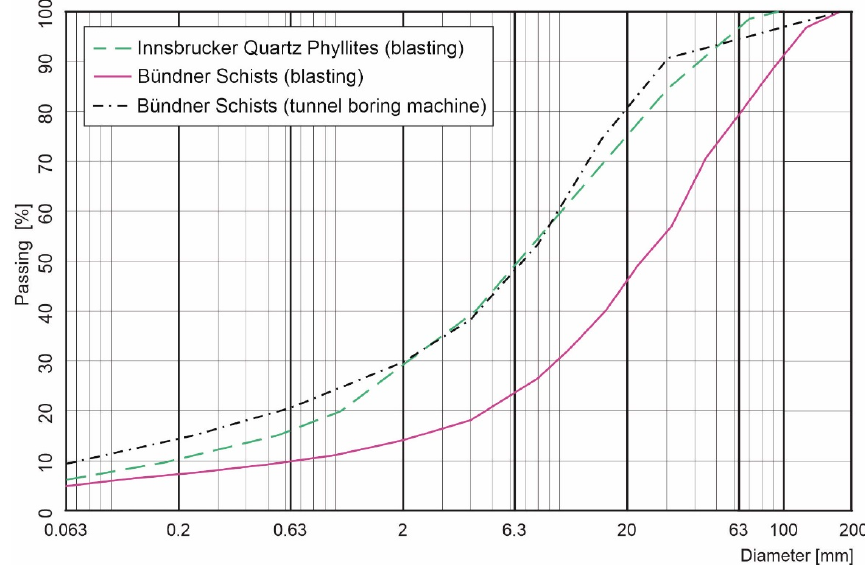
Figure 5. Grain-size distribution from tunnel excavation material (Quartz phyllite from blasting ca. tunnel km 7; Bündner Schists from blasting ca. km 22; Bündner Schists from tunnel boring machine ca. km 15; see Figure 3).